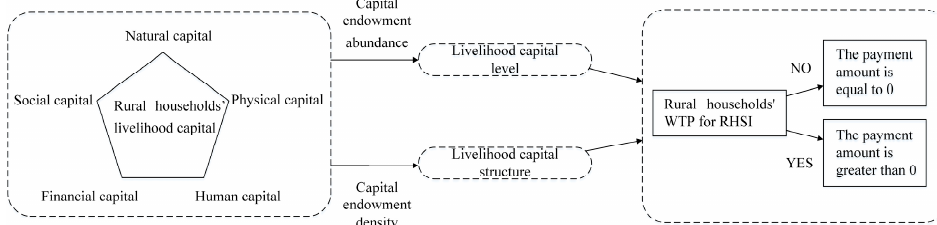
Figure 1. The theoretical analysis framework for this